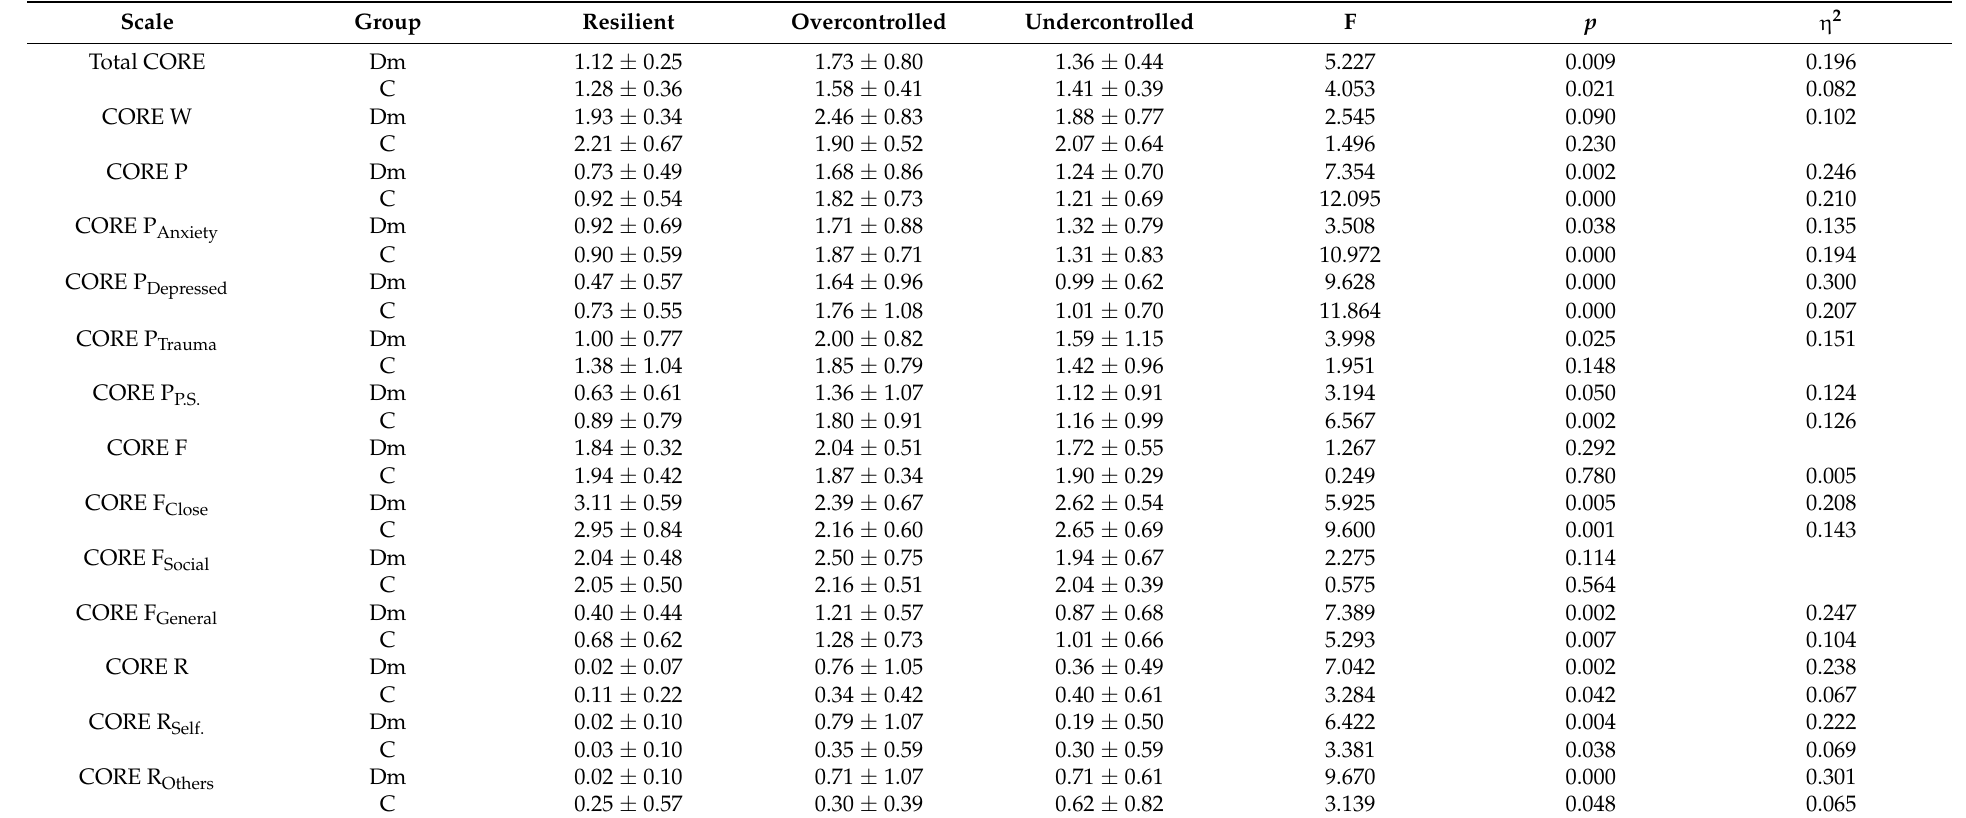
Table 3. CORE-OM questionnaire scores by Asendorpf personality prototype